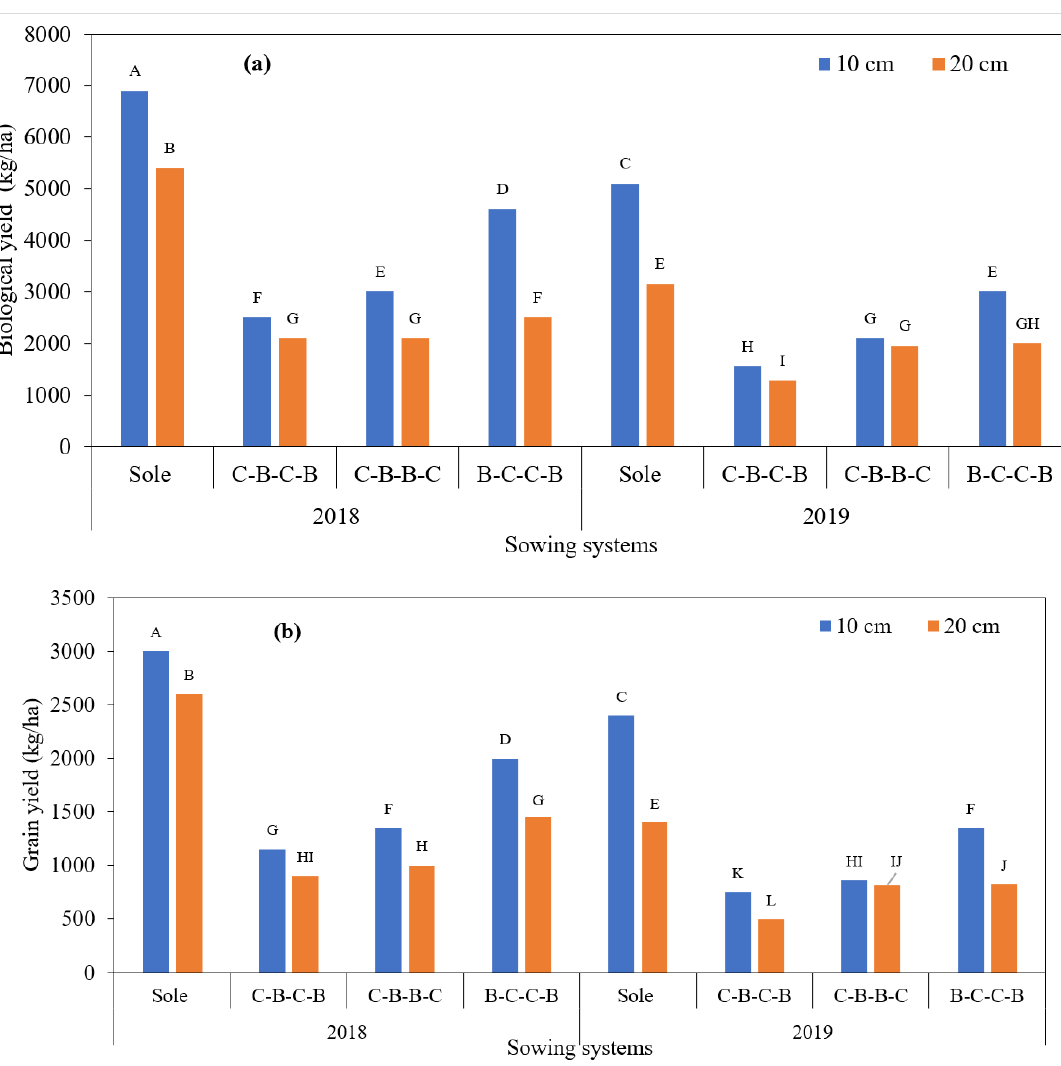
Figure 7. The interactions of maize–white bean sowing systems on biological yield ( a ) and grain yield ( b ) at Nur Sultan, Kazakhstan research station. Letters on each bar represent significance level at p < 0.01. Note: different letters denote significant differences, while the same letters indicate insignificantly different values.